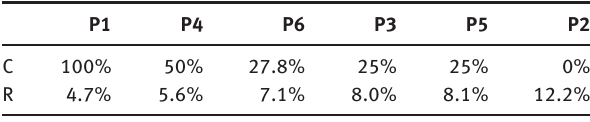
Table 4: Content of 0-direction fibers (C) and reduction in tensile strength (R).